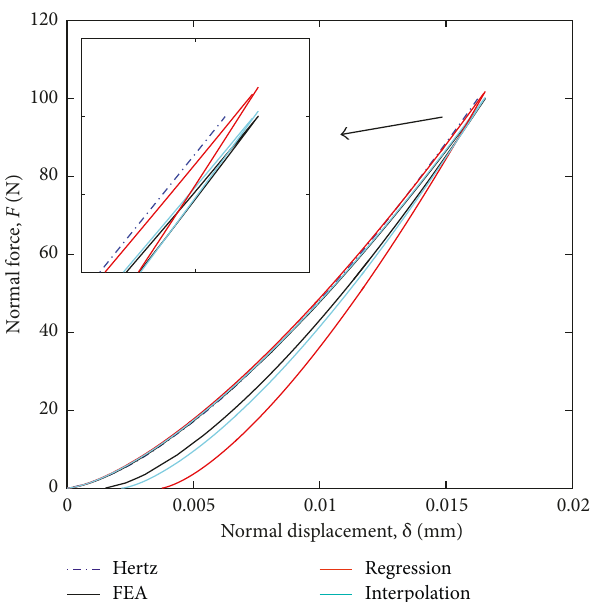
10 GPa. (a) Interpolated sample space; (b) the predicted value. (cid:31)